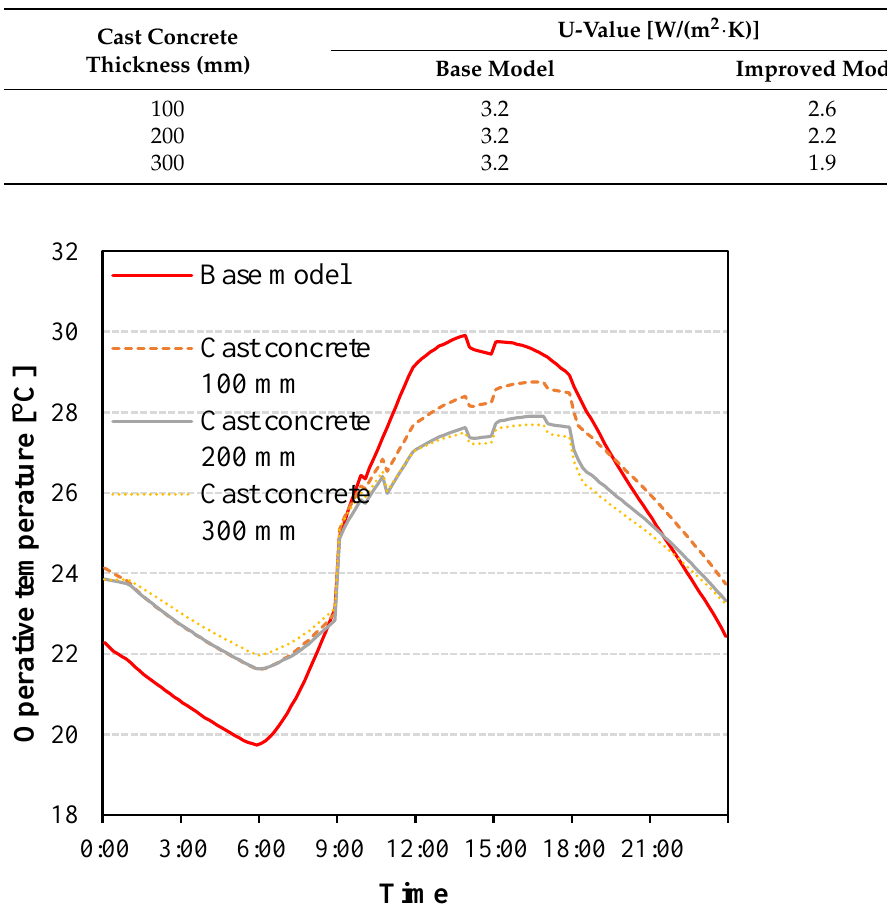
Figure 16. Impact on operative temperature due to use of cast concrete as thermal mass.